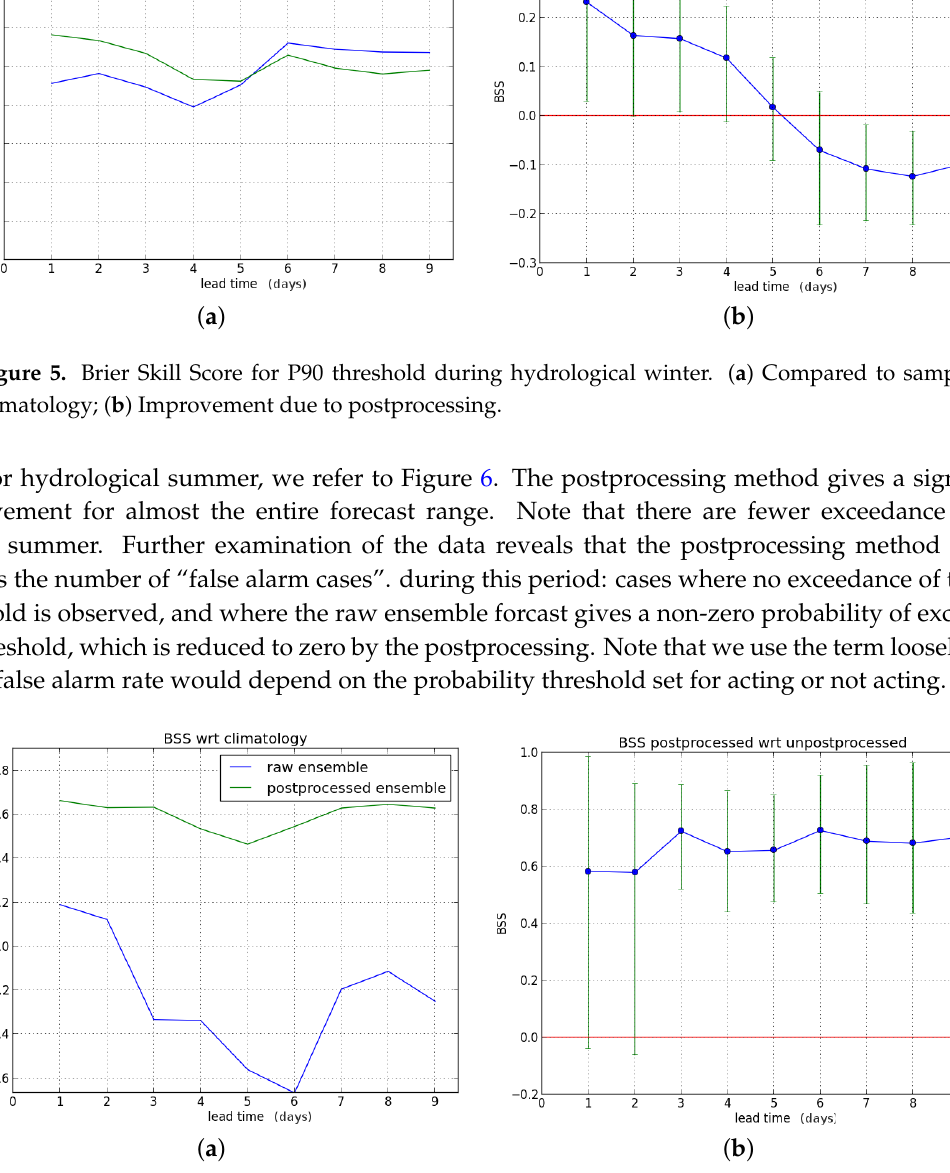
Figure 6. Brier Skill Score for P90 threshold during hydrological summer. ( a ) Compared to sample climatology; ( b ) Improvement due to